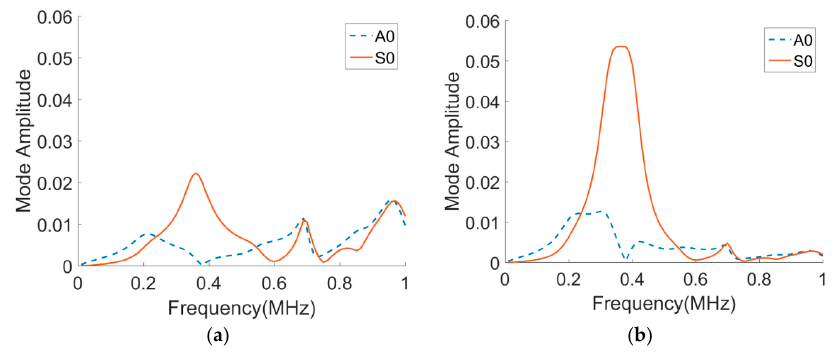
Figure 11. The predicted Lamb wave mode A0 and S0 amplitudes with ( a ) no matching network ( b ) matching at 0.35 MHz. Reproduced with permission from Reference [144], Copyright IOP, 2018.